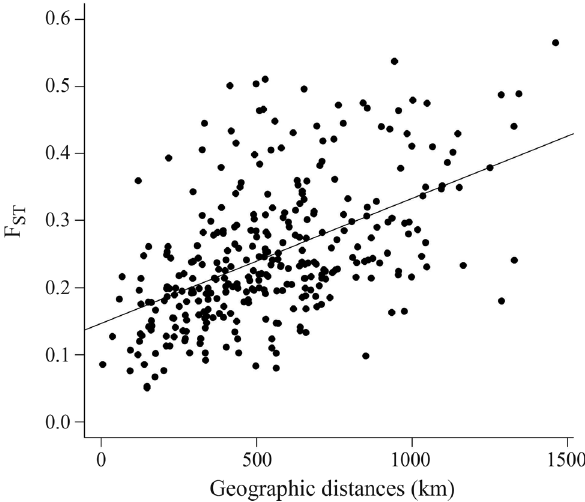
Figure 2 - Relationship between pairwise F ST and geographic distances ( r = 0.499) for the 25 “Baru” populations.